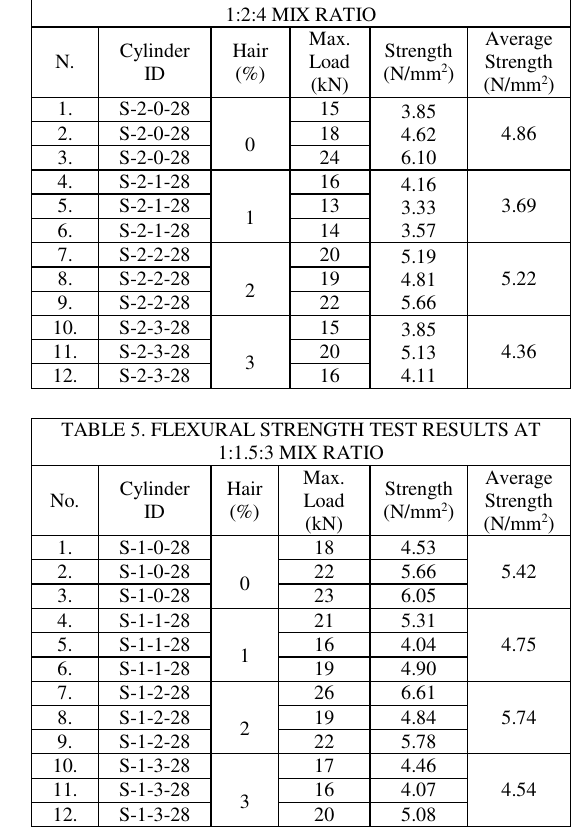
FIG. 5. FLEXURAL STRENGTH OF HSH FIBER CONCRETE